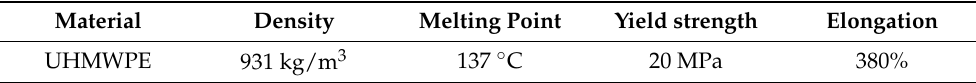
Table 1. Properties of the ultra-high molecular weight polyethylene (UHMWPE) (Chirulen 1050). Material Density